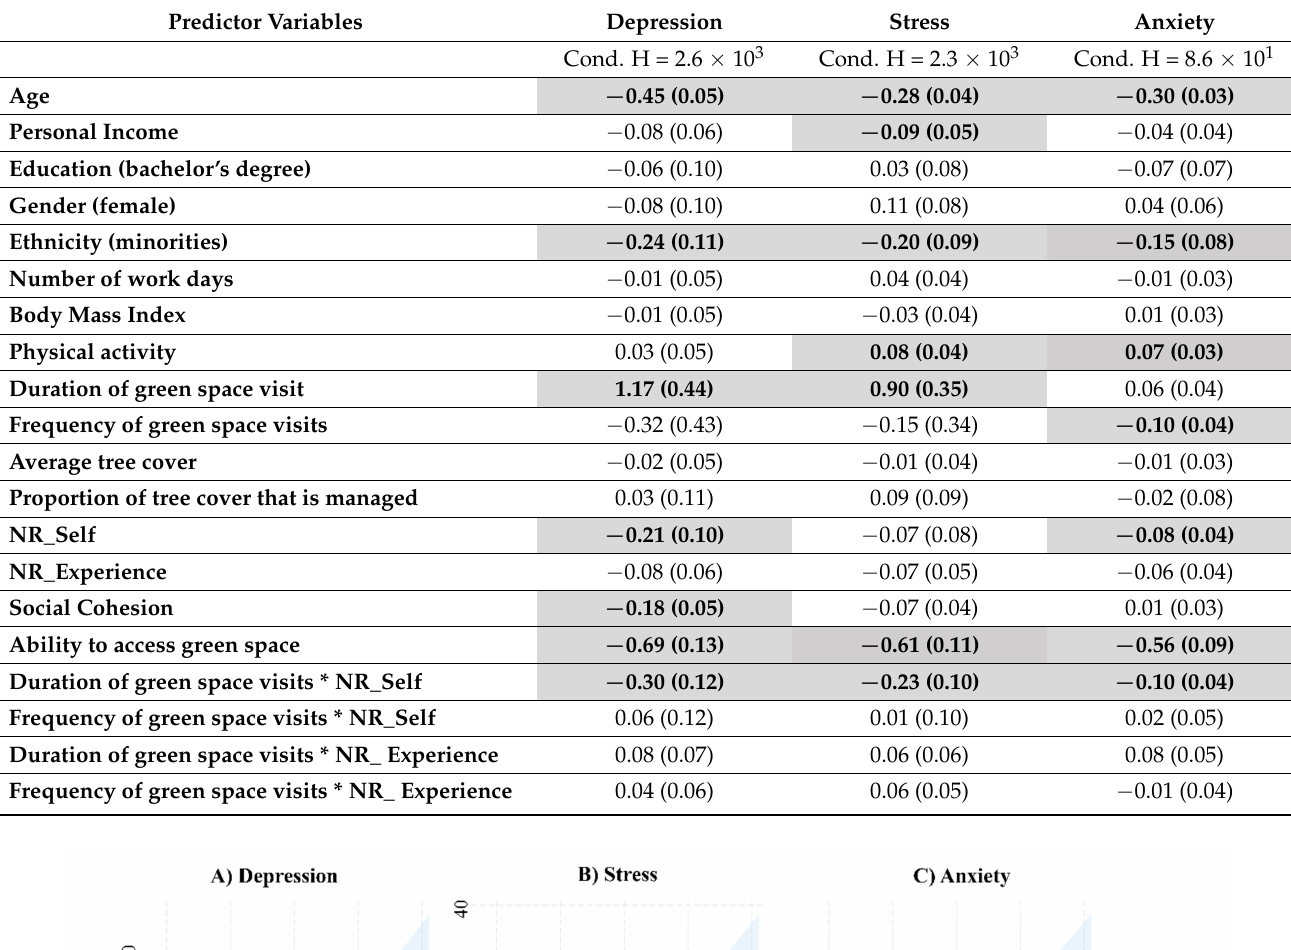
Table 2. The relationship between mental wellbeing outcomes (i.e., depression, stress, and anxiety), socio-demographic covariates, and nature exposure predictor variables. Hessian condition number (Cond. H) and estimated parameter coefficients are presented from the CLMMs, with standard error in brackets; negative coefficients indicate that prevalence of depression, stress, and anxiety are lower with higher values of predictor variables. Table cells shaded in grey (with bold numbers) represent significant predictor variables ( p -value ≤ 0.05). An asterisk represents an interaction between two predictor variables. The estimated parameter coefficients and confidence intervals for categorical factors are presented relative to a comparative base factor level: Education: no bachelor’s degree; gender: male; ethnicity: majority Chinese; inability to access green space because of poor health).